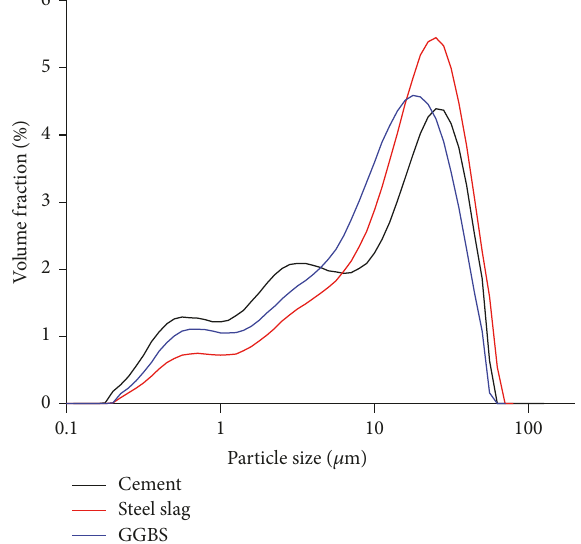
Figure 1: The particle size distributions of the cement, GGBS, and steel